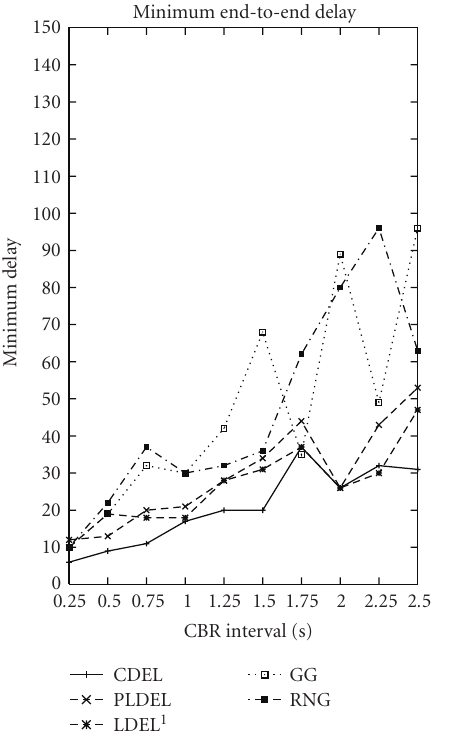
Figure 11: Minimum delay in μ sec.